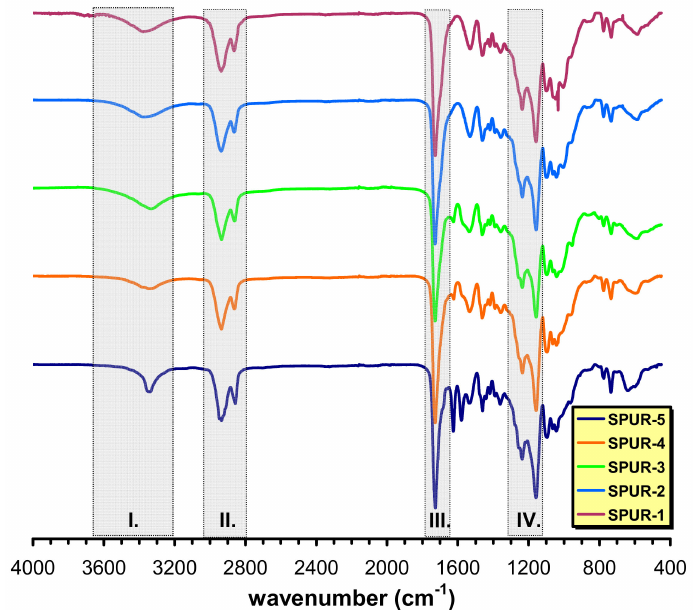
Figure 1. ATR-FTIR spectra of the SPUR